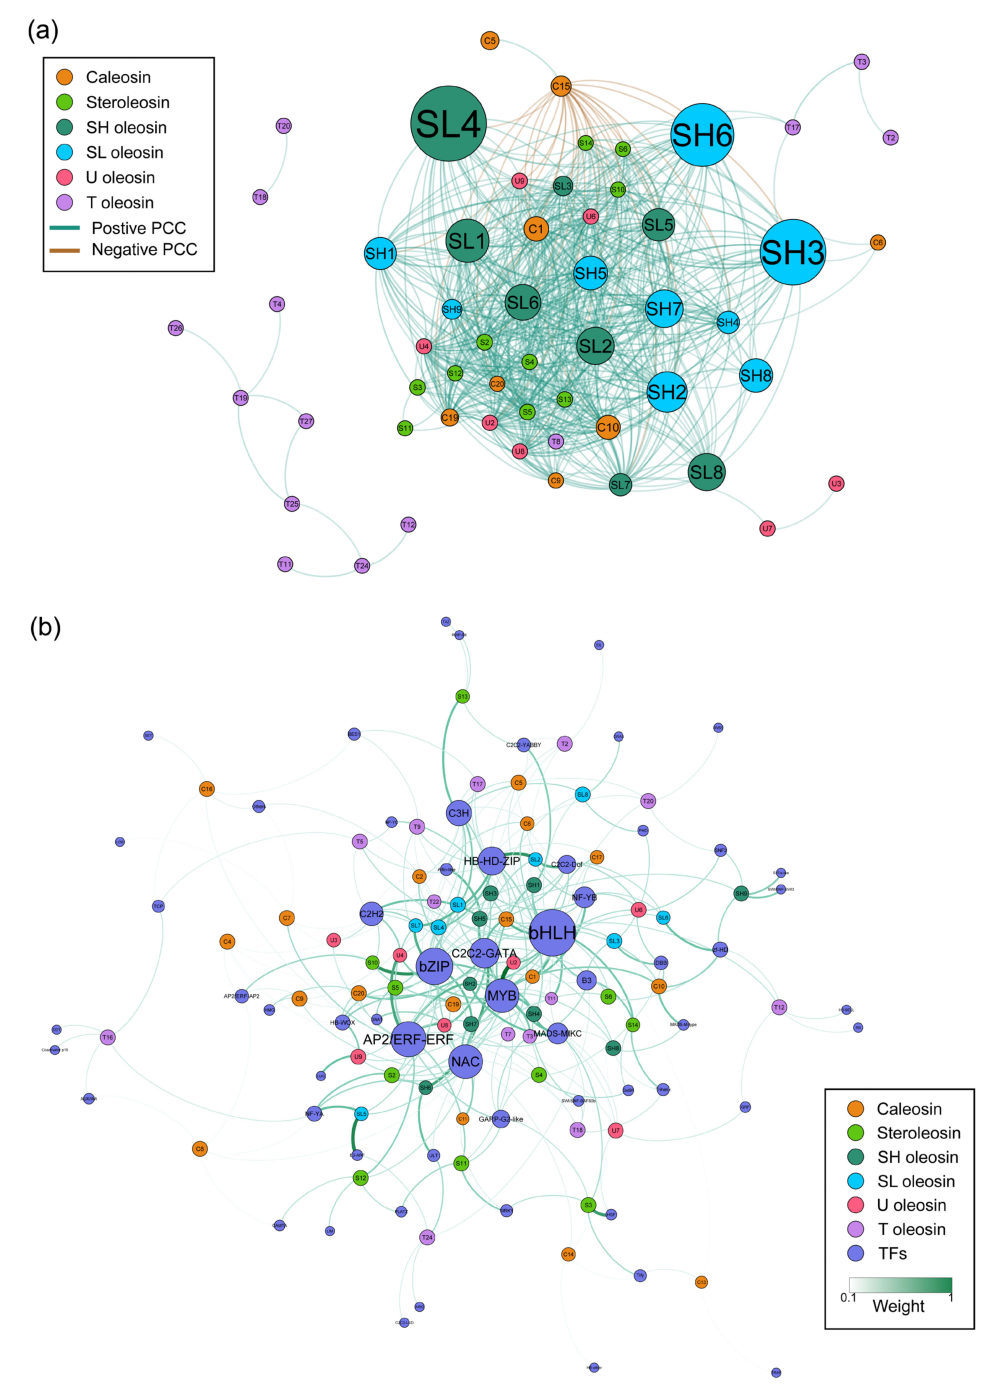
Figure 8. Co-expression and gene regulatory networks of BnaOBMP genes during seed development. ( a ) Co-expression network of BnaOBMP genes. The OBMP gene families are marked by different colors as shown in the color legend at the top left. The sizes of circles indicate the average expression levels of the BnaOBMP genes. The lines represent the positive (green) and negative (brown) correla- tions between BnaOBMP genes. ( b ) Gene regulatory networks of the BnaOBMP genes. The OBMP gene families and TFs are marked by corresponding colors shown in the color legend at the bottom right. The size of the circles indicates the degree of each node. The color and thickness of the lines represent the weight between TFs and BnaOBMPs from weak (white) to strong (green). The gene names are labeled on the